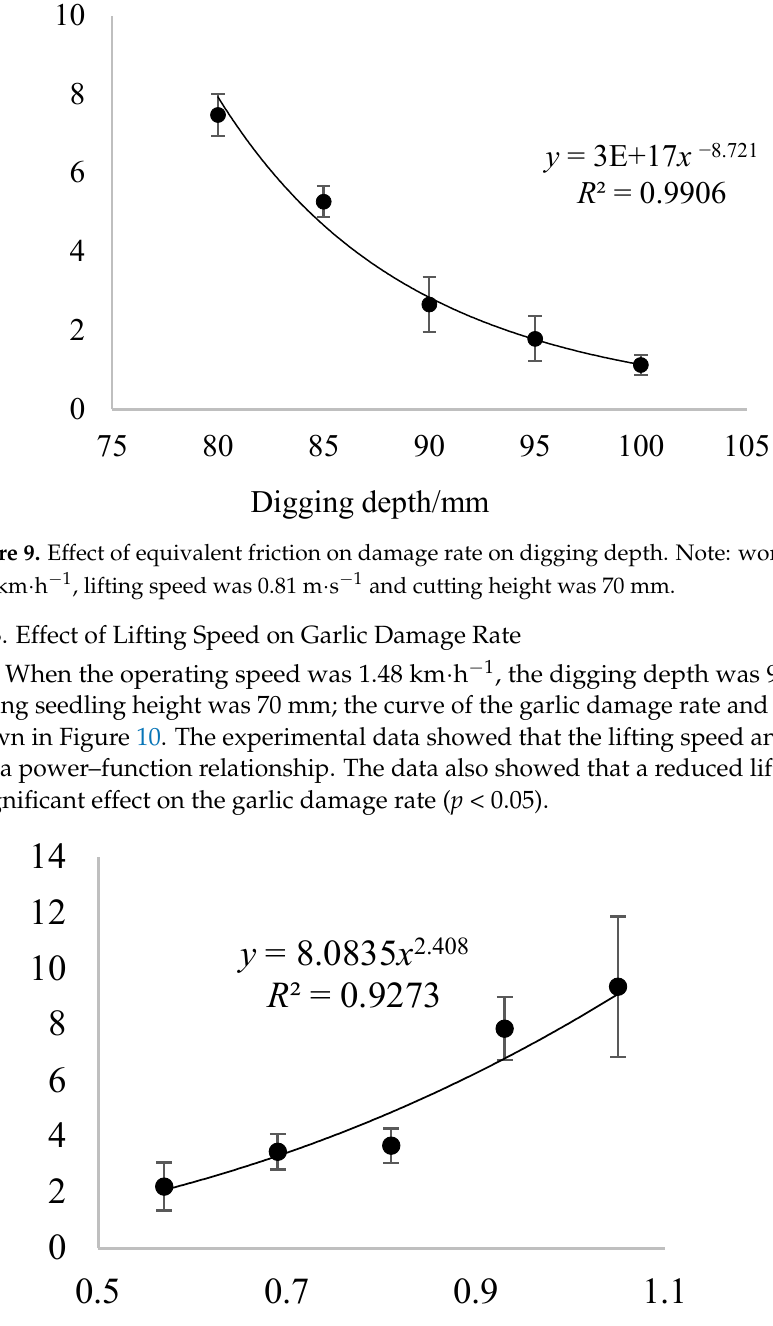
Figure 8. Effect of equivalent friction on damage rate on working speed. Note: digging depth was 90 mm, lifting speed was 0.81 m·s − 1 and cutting height was 70 mm.